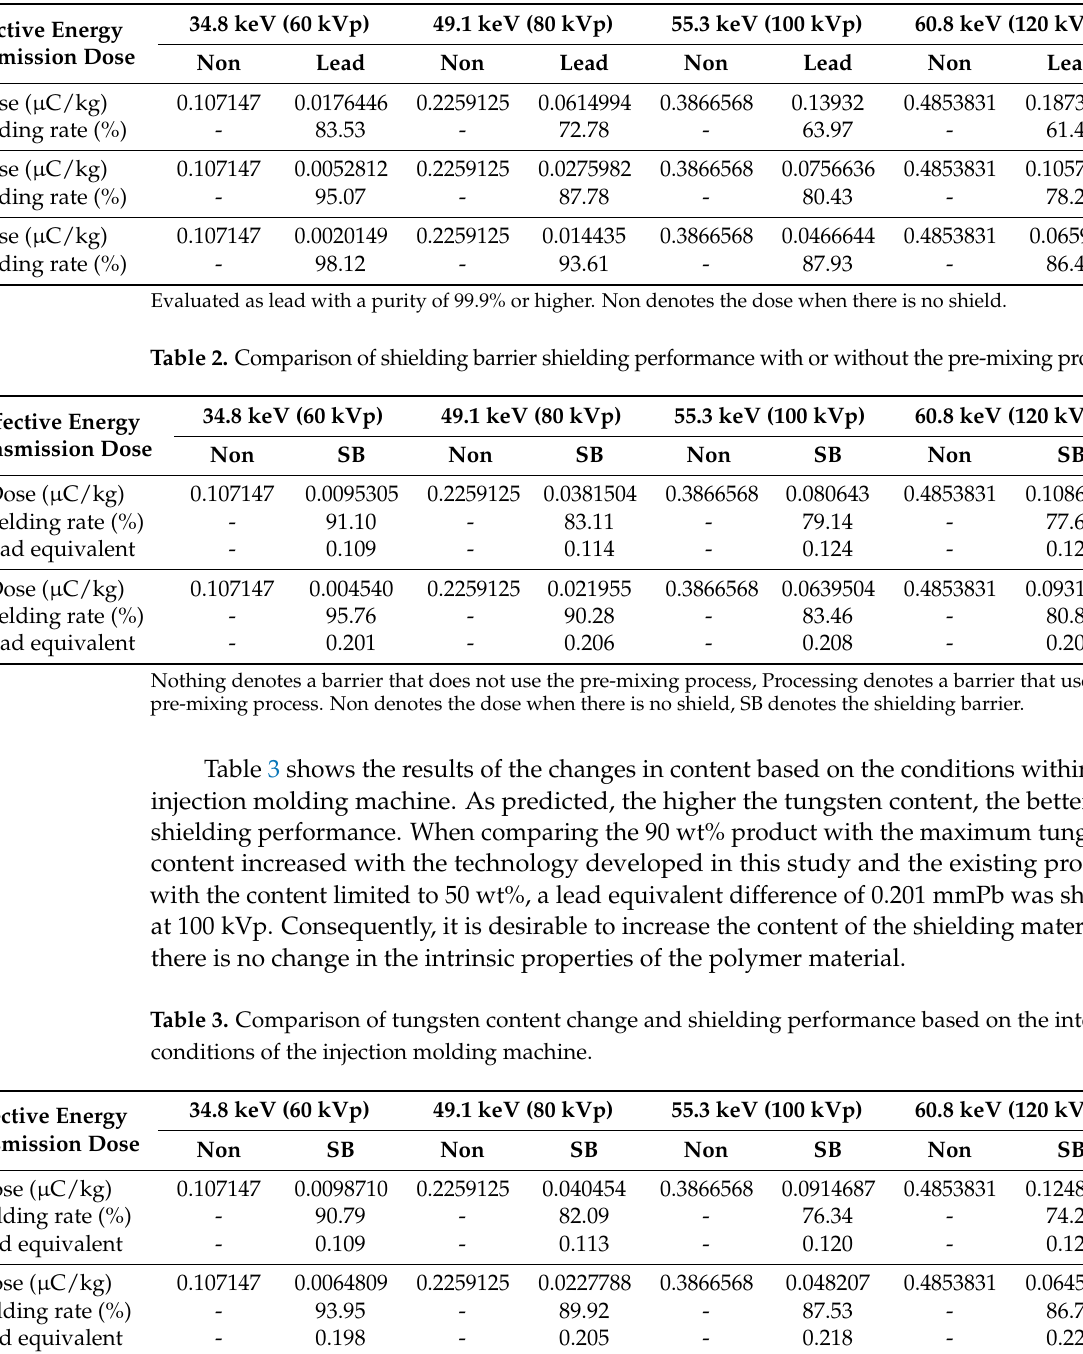
Table 1. Shielding performance evaluation of standard lead (0.1 mm, 0.2 mm, 0.3 mm).